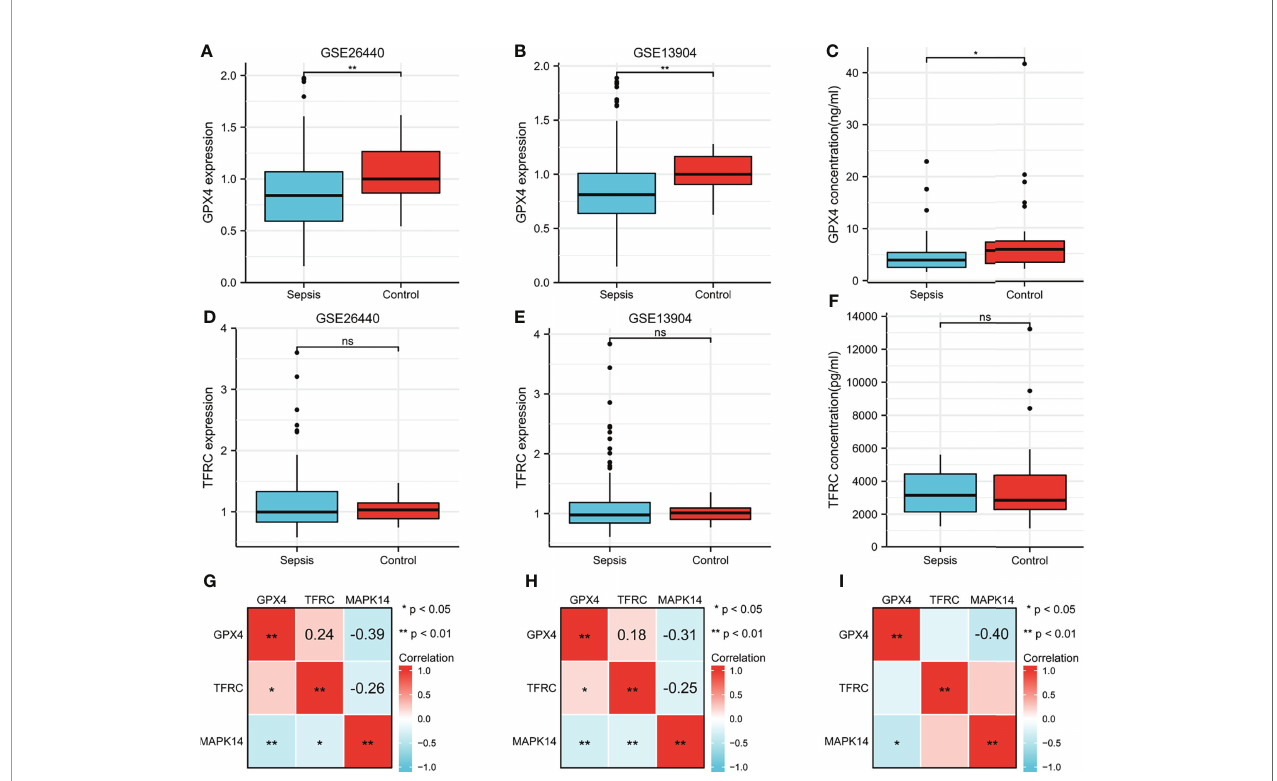
FIGURE 9 | Difference of GPX4 and TFRC in sepsis and control. GPX4 expression between sepsis and control in (A) GSE26440 cohort and (B) GSE13904 cohort. (C) Serum GPX4 concentration between sepsis and control in our ELISA result. TFRC expression between sepsis and control in the (D) GSE26440 cohort and (E) GSE13904 cohort. (F) Serum TFRC concentration between sepsis and control in our ELISA result. Correlation analysis between GPX4, TFRC, and MAPK14 in sepsis in the (G) GSE26440 cohort and (H) GSE13904 cohort and (I) our ELISA result. *P < 0.05; **P < 0.01; "ns", not signi fi